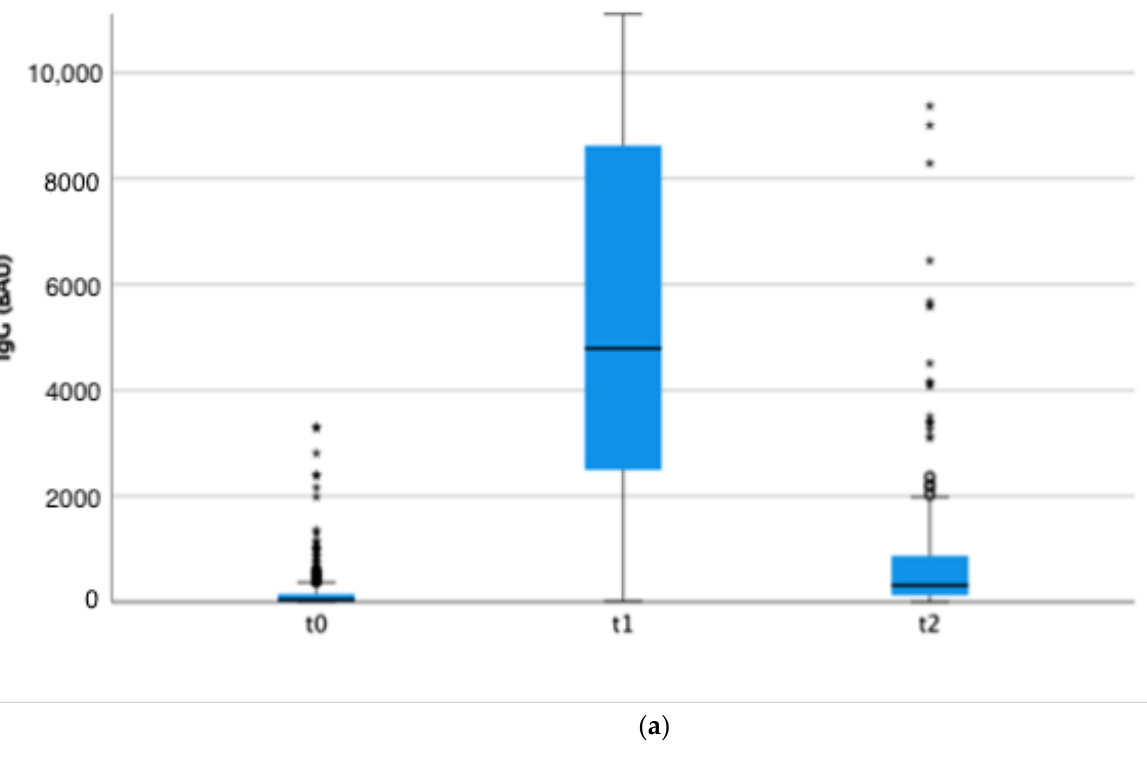
( b ) Figure 2. Box plots of anti-SARS-CoV-2 IgG titres (BAU/mL) among all study participants (t0: N = 534, t1: N = 404, t2: N = 314). ( a ) t0, t1 and t2; ( b ) t0 vs. t2. * and circles: outliers